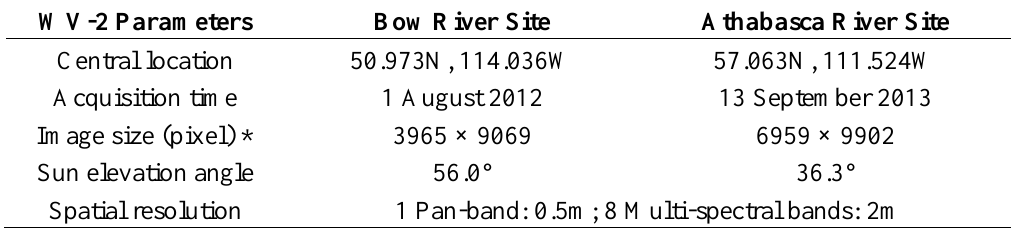
Table 1. The specific parameters of input